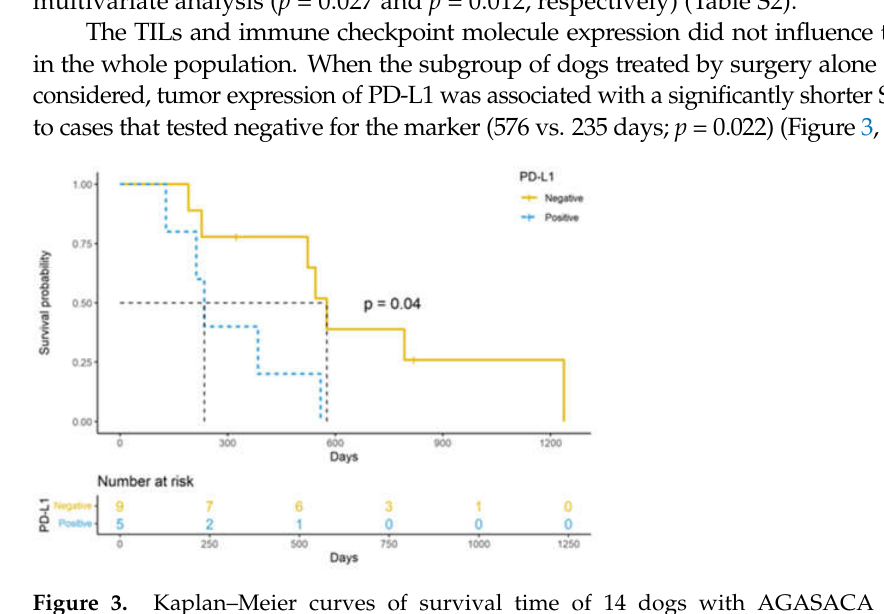
(53.7%) had died for causes attributable to AGASACA (range: 128–1237 days), 14 (34.1%)